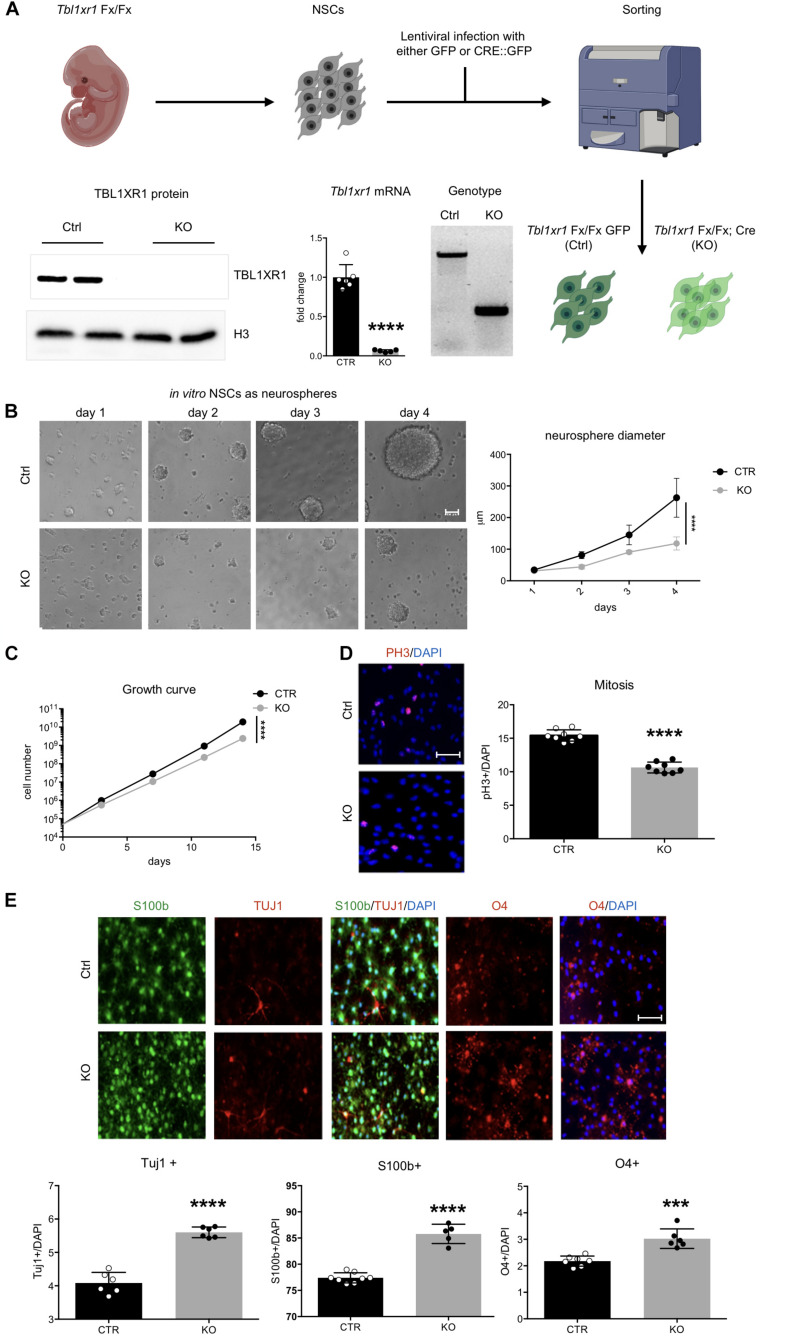
Loss of Tbl1xr1 affects neural stem cells dynamics. (A) Scheme of NSC derivation with examples of: genotyping (by PCR), expression of Tb1xr1 (mRNA abundance by RT-qPCR, ****p < 0.0001, unpaired t-test), and TBL1XR1 protein level (by Western blot). (B) NSCs both Ctrl and KO cultured as neurospheres, on the right quantification of spheres’ diameter: difference due to genotype, F(1,40) = 63.19, ****p < 0.0001, 2-way ANOVA. (C) Growth curve of adherent in vitro NSCs: difference due to genotype, F(1,4) = 535.6, ****p < 0.0001, 2-way ANOVA. (D) Immunocytochemistry of both Ctrl and Tbl1xr1 KO proliferating NSCs for phosphor histone 3 (PH3) counterstained with DAPI. On the right, quantification of PH3+ cells on total DAPI nuclei, ****p < 0.0001, unpaired t-test. (E) Up, immunocytochemistry of both Ctrl and Tbl1xr1 KO differentiating NSCs for S100b (astrocytes), TUJ1 (neurons) and O4 (oligodendrocytes) counterstained with DAPI. Bottom, quantification: TUJ1: ****p < 0.0001, unpaired t-test; S100b: ****p < 0.0001, unpaired t-test; O4: ***p = 0.0002, unpaired t-test. Scale bars: (B) 40 μm; (D,E) 50 μm.